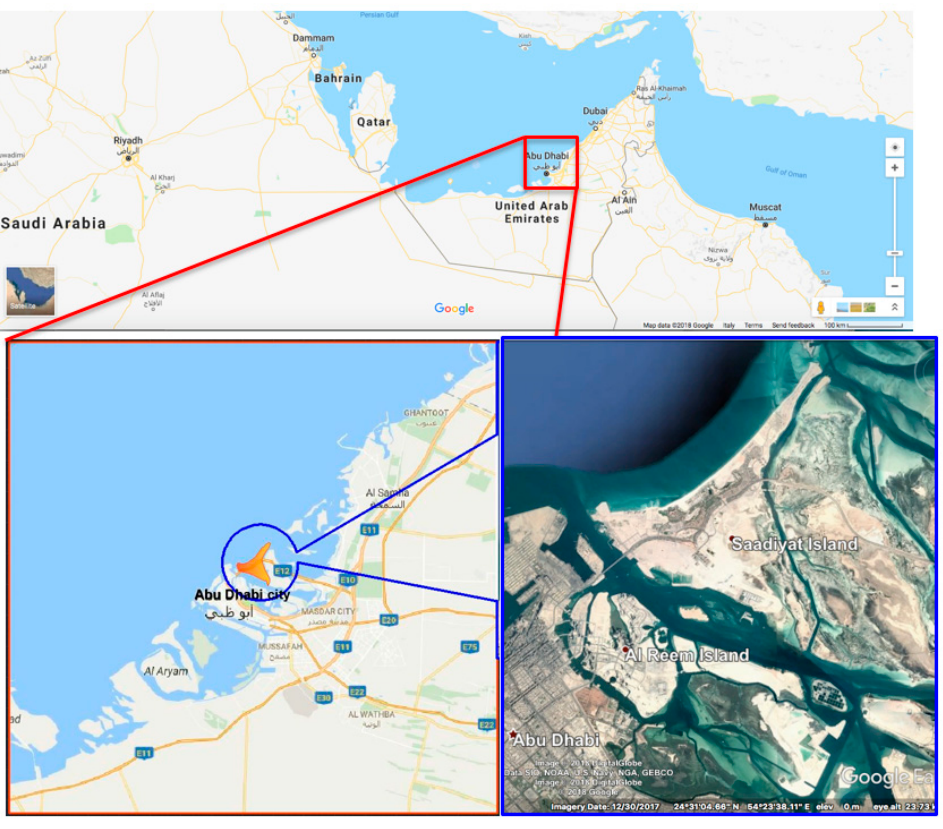
Figure 1. Aerial view of Saadiyat beach.